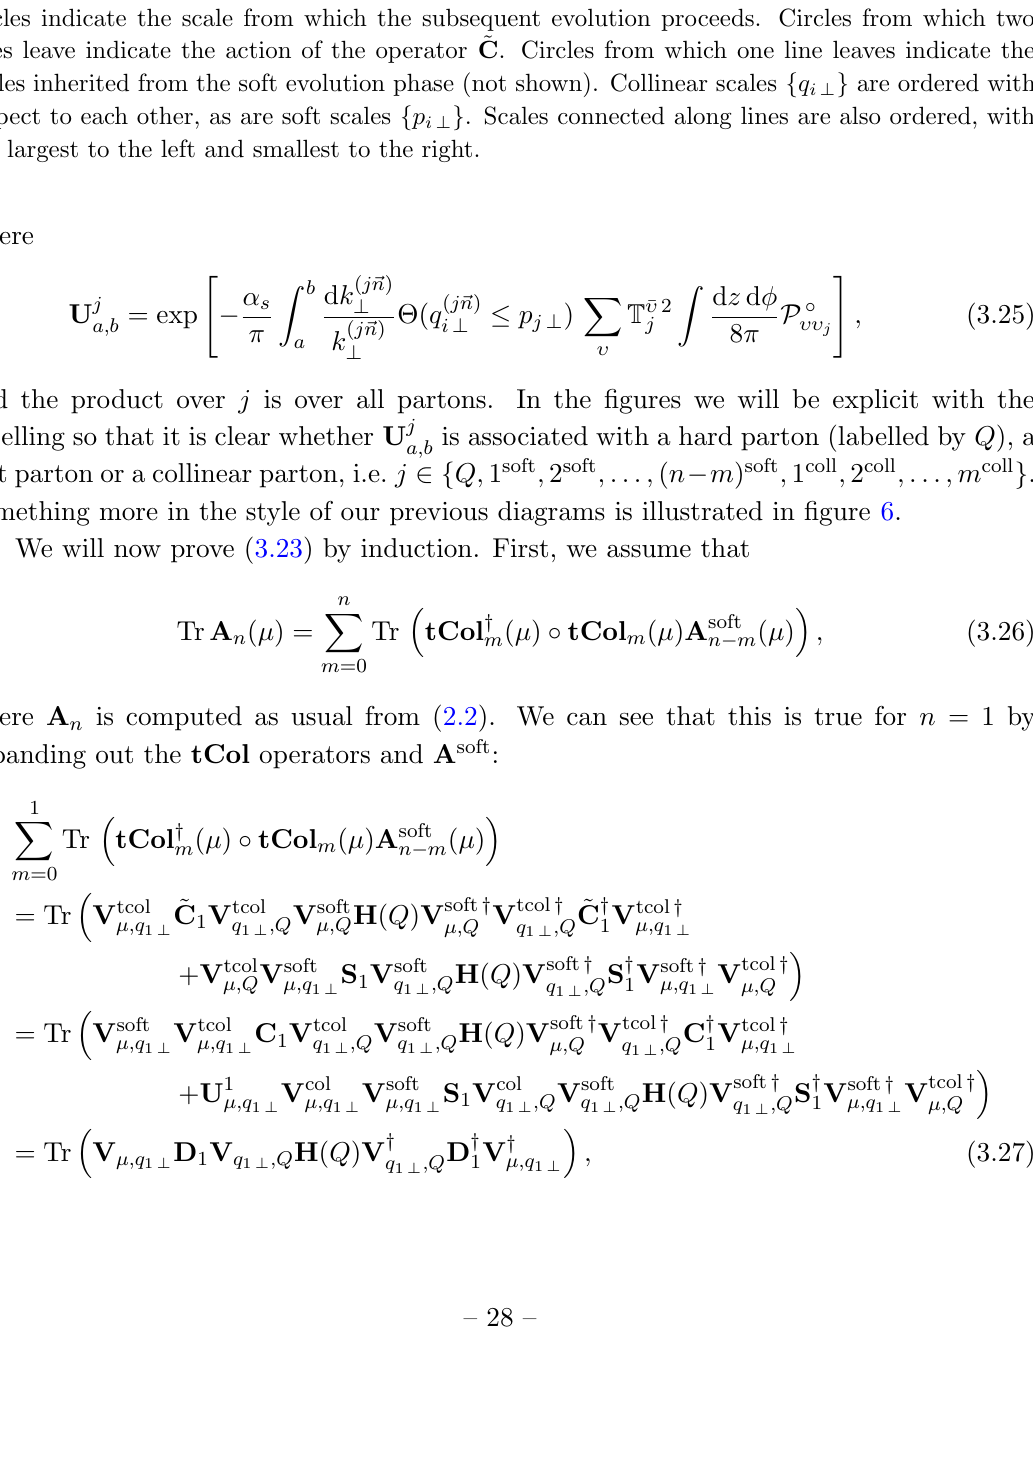
. Red dashed lines represent soft gluons and 4 q i ? are ordered with f g p i ? . Scales connected along lines are also ordered, with f g